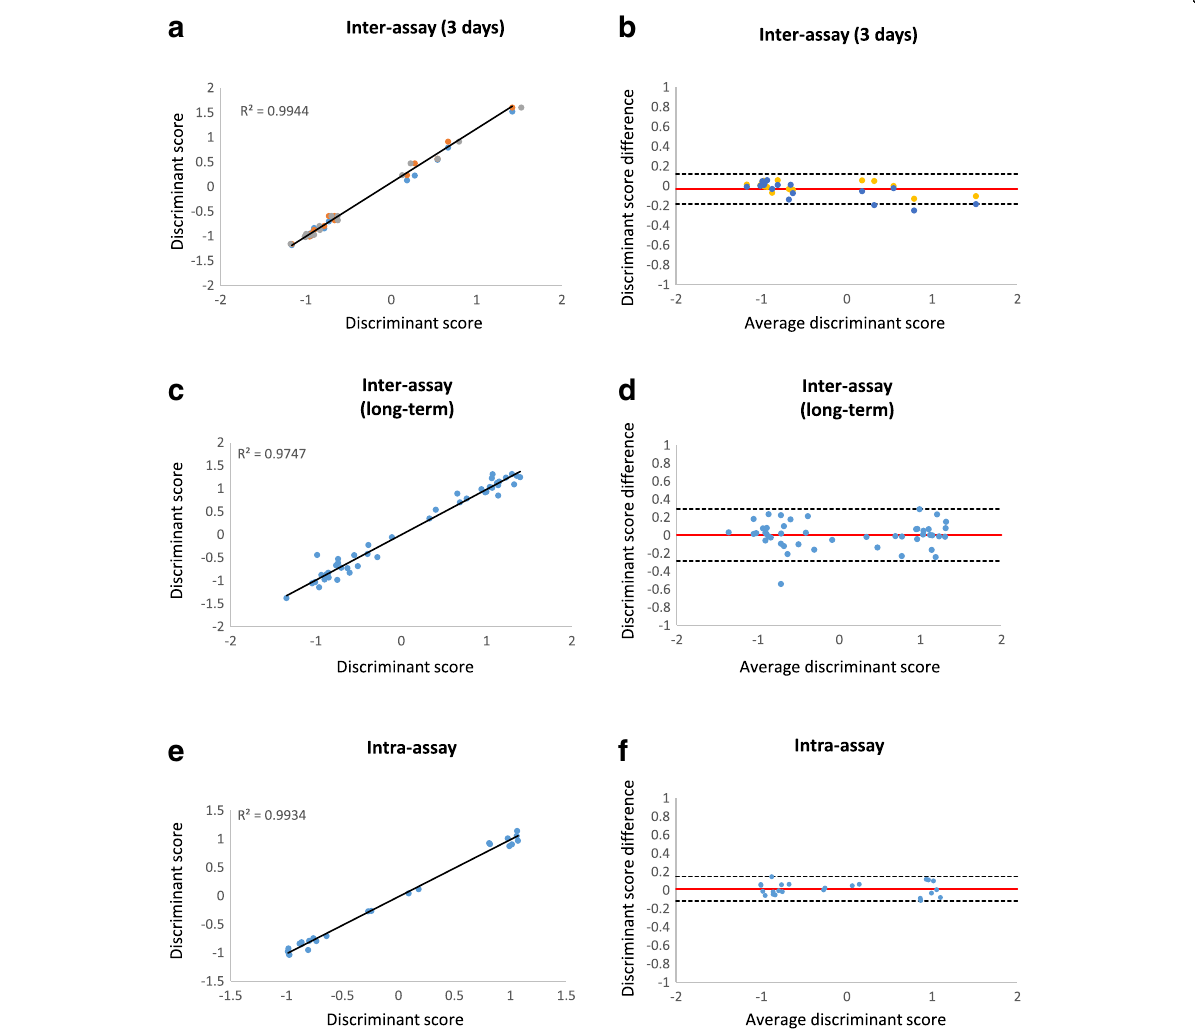
Fig. 2 Inter- and intra-assay reliability of DecisionDx-UM. a Inter-assay correlation of discriminant scores for 16 samples run on 3 consecutive days. b Bland-Altman plot showing the difference in discriminant scores between runs and the 95% confidence interval ( dashed lines ). The estimated bias (or mean difference in discriminant values) is represented as the red line . c Inter-assay correlation of discriminant scores of 46 samples run twice during a one-year period for proficiency testing or instrument verification. d Bland-Altman plot of proficiency testing and instrument verification samples. e Intra-assay correlation of discriminant scores of 12 samples tested in duplicate on two cards. f Bland-Altman plot showing differences in paired discriminant scores within each